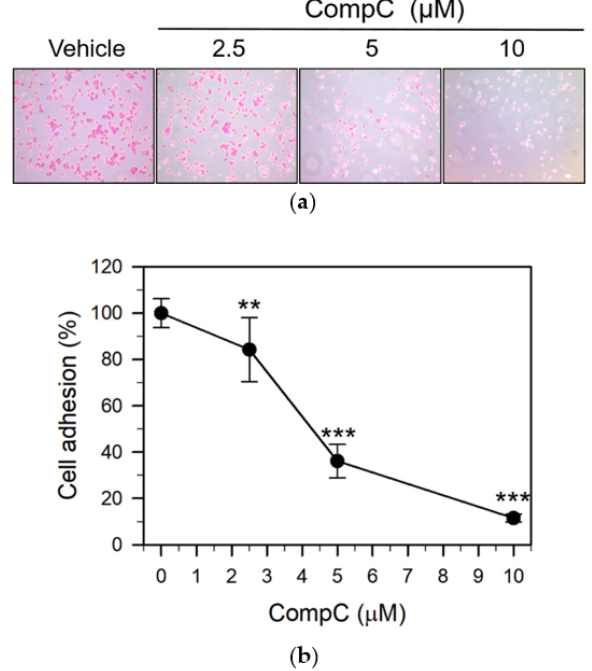
Figure 6. CompC inhibited the in vitro adhesion of Renca cells. A Renca cell suspension in SFM (2 × 10 4 cells per well) was seeded to Matrigel-coated 96-well plates. The cells were treated with the vehicle or various concentrations (2.5, 5, and 10 μ M) of CompC and allowed to attach during incubation at 37 °C for 1 h. Adherent cells were fixed and stained with 0.1% crystal violet for 30 min. ( a ) The adherent cells were air-dried and photographed using an inverted microscope (100×). ( b ) The percentage of cell adhesion was calculated by extracting the dye with SDS-ethanol solution (5% SDS, 50% ethanol) and measuring the absorbance at 570 nm. The percentage was plotted as the mean ± SD with n = 10. ** p < 0.01 and *** p < 0.001 compared with vehicle-treated control cells.